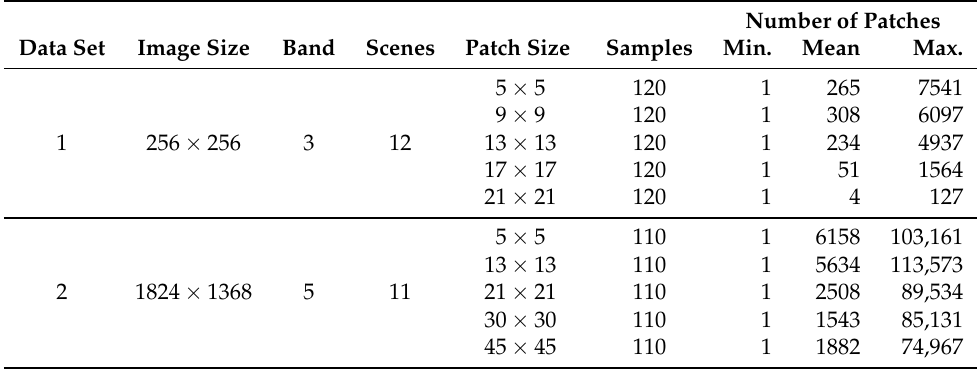
Table 1. The number of ground truth